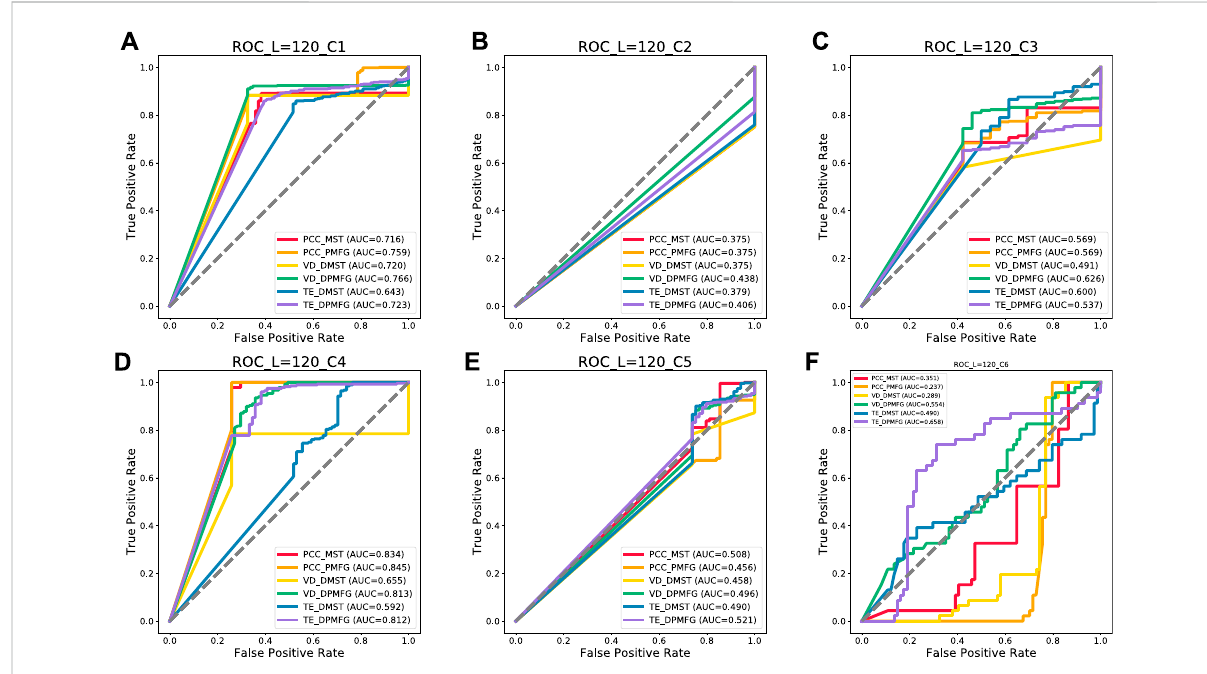
FIGURE 16 Predictionresultsofeachlayerofthenetworkat120-daywindows. (A – F) indicatethepredictionresultofeach fi nancialcrisis.C1toC6indicate the following crises: Subprime Mortgage, European Sovereign Debt, Russian Recession, Stock Market Selloff, and Trade Con fl ict betweenChina and the United States, US stock circuit breaker, respectively.